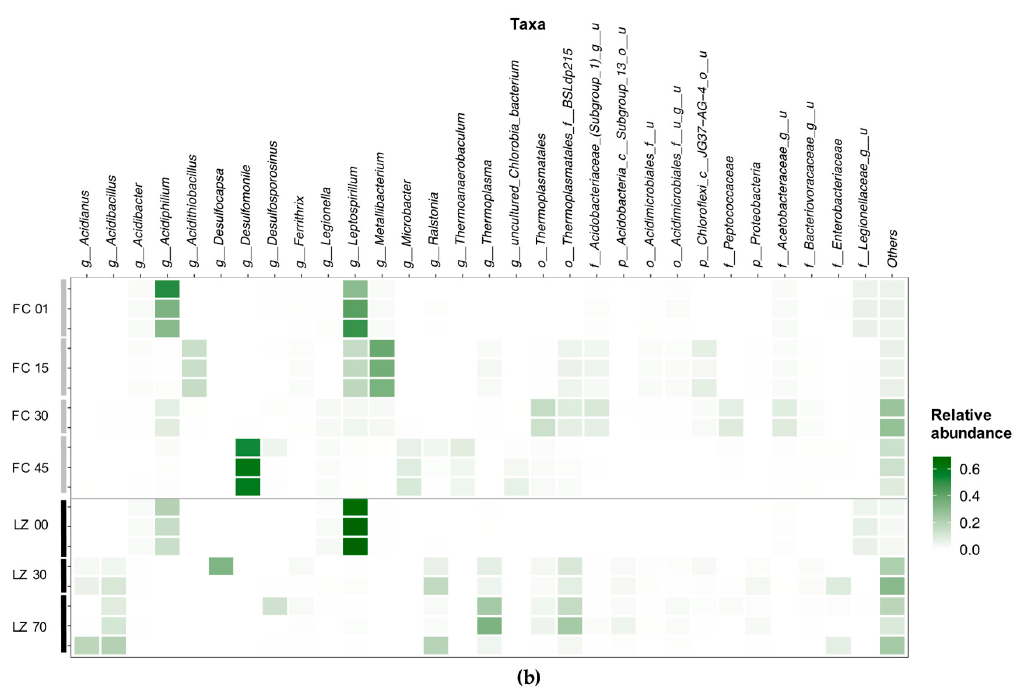
Figure 7. ( a ) Phylum-level composition in replicate samples of Filón Centro (FC, grey bars) and La Zarza (LZ, black bars) expressed as relative read abundance; ( b ) relative read abundance heatmap of the top 30 genera in individual replicates obtained per site, p_, c_, o_, f_, and g_ denote phylum-, class-, order-, family- and genus-level assignment of ESVs, respectively.